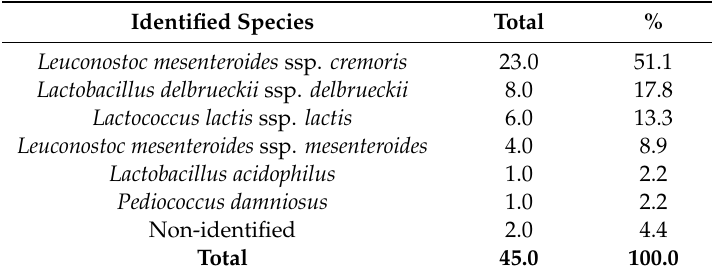
Table 3. Identified lactic acid bacteria from Man, Rogosa and Sharpe agar (MRS), in number of isolates and respective percentage from the total of lactic acid